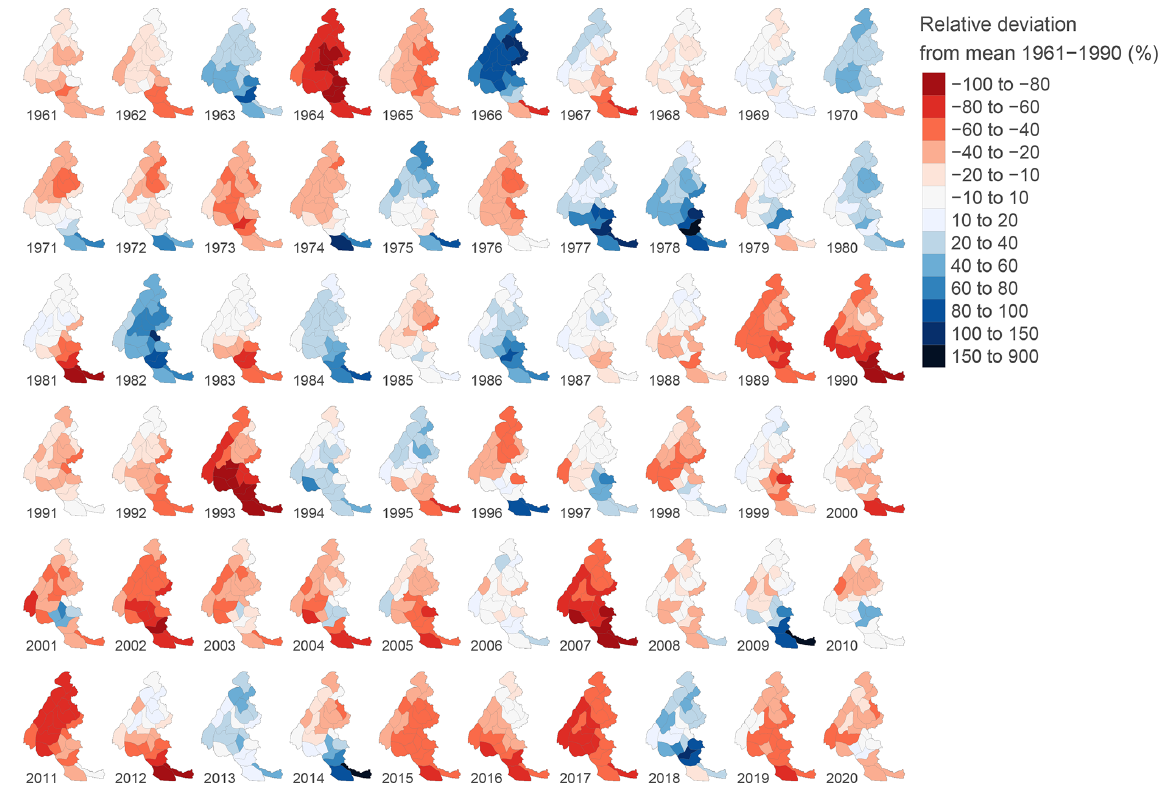
Figure 8. Mean deviation of natural snow depth (in meters) from the mean snow depth of the period 1961–1990 (Fig. 7) in winter (from November to April) at